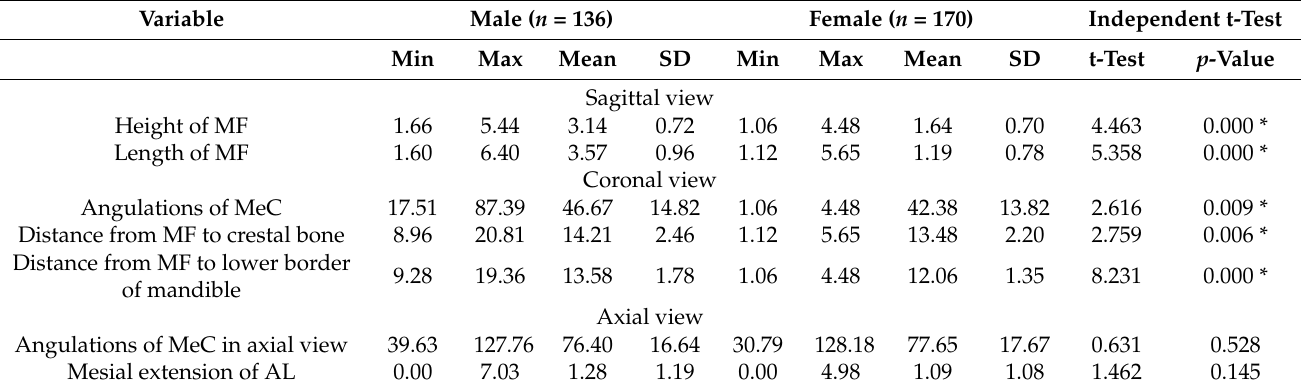
Table 3. Analysis of the dimensions (in mm) and distance (in mm) of the mental foramen, angulation of the mental canal, and extension of the anterior loop on both sexes ( n = 306 images).